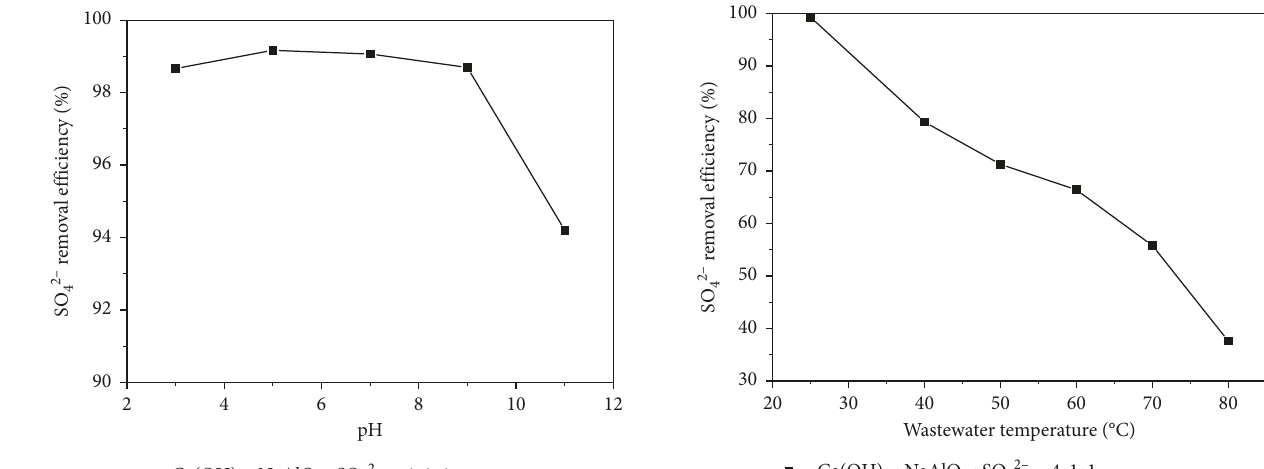
solution (cid:27) 1L,